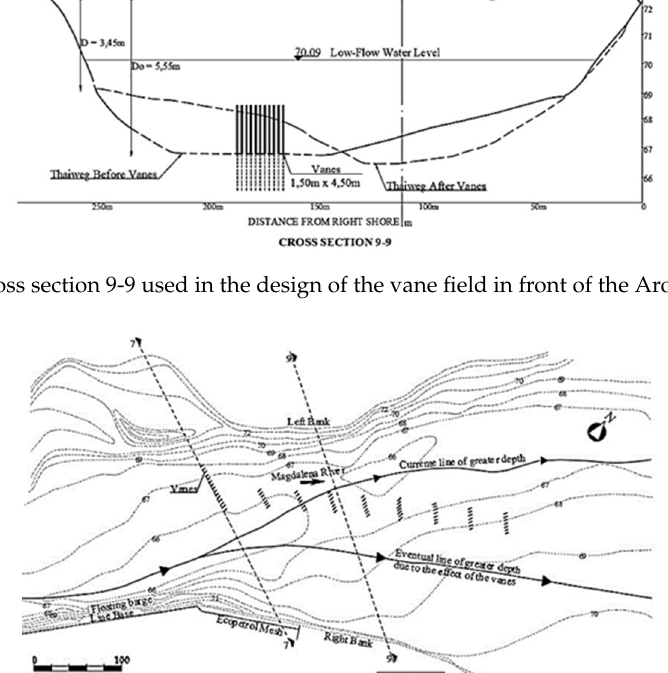
Figure 3. Location of the submerged vane field in front of ECOPETROL's Aromatics pier (Hidroconsulta, 1991).